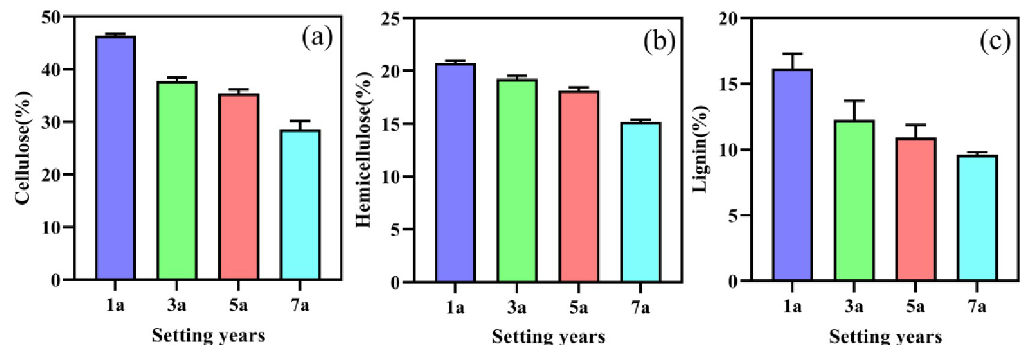
Fig 2. Changes in main chemical compositions under different setting years of S . psammophila sand barriers. (a): Cellulose, (b): Hemicellulose, (c): Lignin.